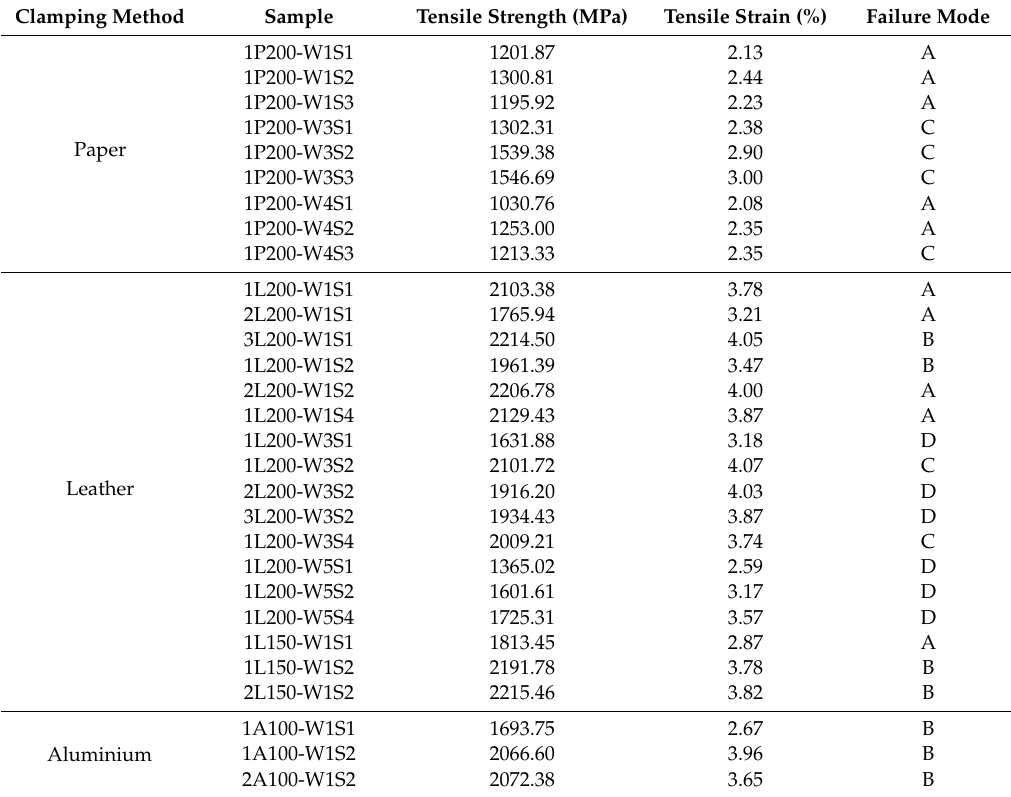
Table 3. Results of the basalt grid strips tested without the video-extensometer.